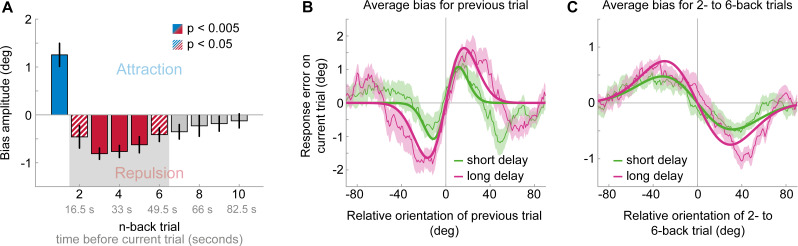
Results of Experiment 3: Long-term repulsive biases are not strongly modulated by working memory delay.(A) Attraction and repulsion biases exerted by the 10 preceding stimuli, pooled across response delay conditions. The current response is attracted towards the previous stimulus, but repelled from stimuli seen 2 to 6 trials ago. Colored bars indicate significant attraction (blue) and repulsion (red) biases (solid: Bonferroni correction for multiple comparisons; striped: no multiple comparison correction). Error bars represent 1 SD of the bootstrap distribution. The gray shaded area marks the time window of interest for which we estimated the working memory delay dependence of the repulsive bias (panel C). (B) Serial dependence on previous stimulus, considering trials for which the delay between current stimulus and response was short (green) or long (pink). Attractive serial dependence increases with working memory delay on the current trial. Shaded region depicts the SEM of the group moving average (thin lines). Thick lines show the best fitting DoG curves. Same data shown in Experiment 4 by Fritsche et al., 2017. (C) Average serial dependence on 2- to 6-back stimuli for current short (green) or long (pink) working memory delays. There is a trend towards a stronger repulsive bias when the current working memory delay is long. However, this difference between delay conditions was not significant.Figure 4—source data 1.Results of Experiment 3: Long-term repulsive biases are not strongly modulated by working memory delay.The source data file contains a csv file with the 1- to 10-back DoG model parameter estimates and a csv file with p-values for testing the model’s amplitude parameters against zero. It also contains two csv files with model parameters fit to 1-back or 2- to 6-back conditioned response errors, split by memory delay duration. Furthermore, it contains a mat file with all 1- to 10-back moving averages of each participant (short and long memory delay).